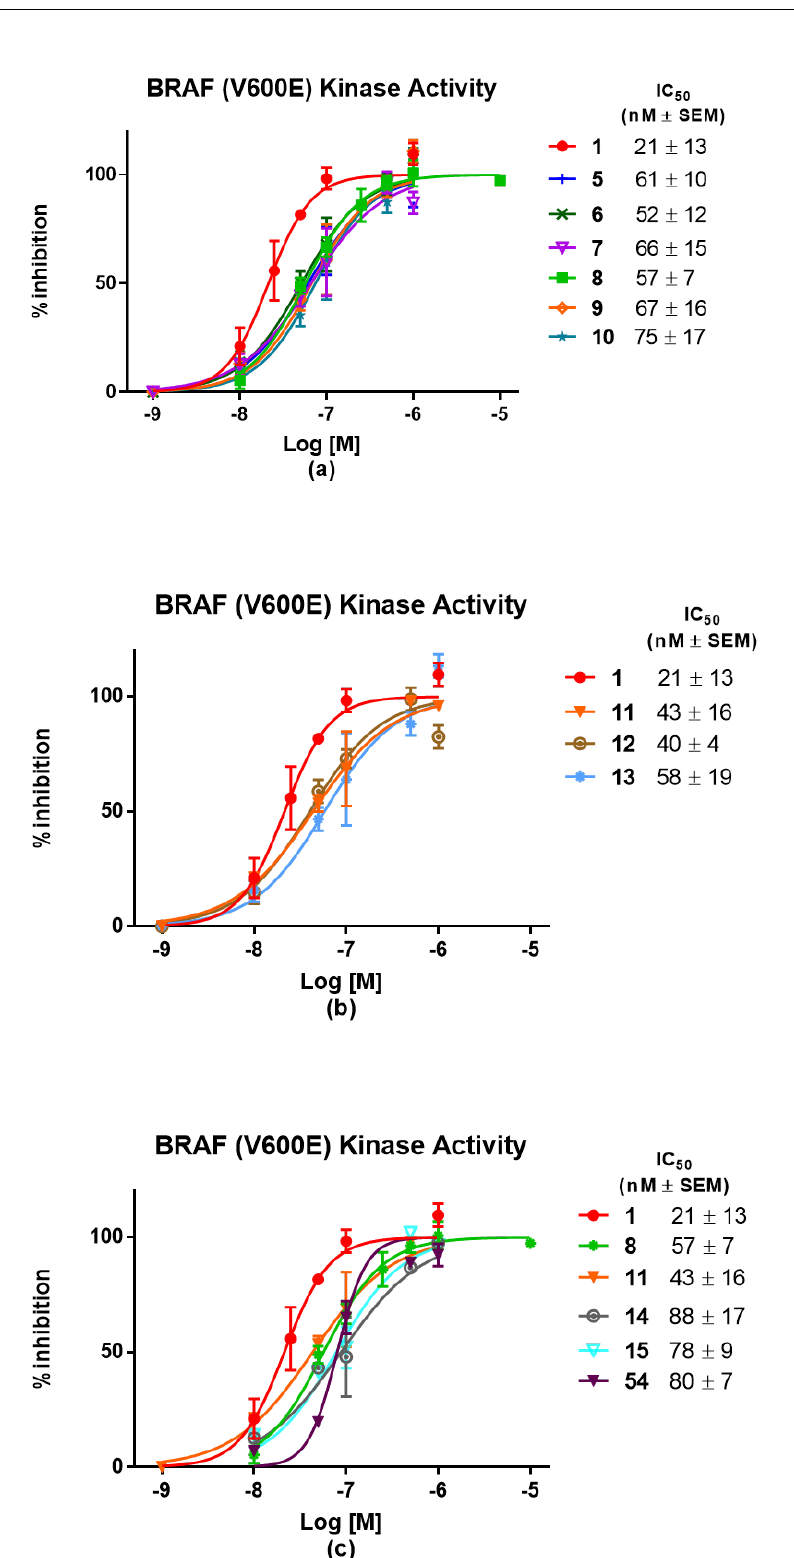
Figure 4. Concentration–response curves for isolated BRAF V600E inhibition for compounds 5 – 15 , 54 and encorafenib ( 1 ). ( a ) Comparison of compounds with flexible PEG-type linkers of different length; ( b ) Comparison of compounds with triazole ring-type linker of different length; ( c ) comparison of compounds with different E3 ligase ligands of similar length or lacking the E3-ligase binder ( 54 ). Data are the results of three different experiments run in duplicate.